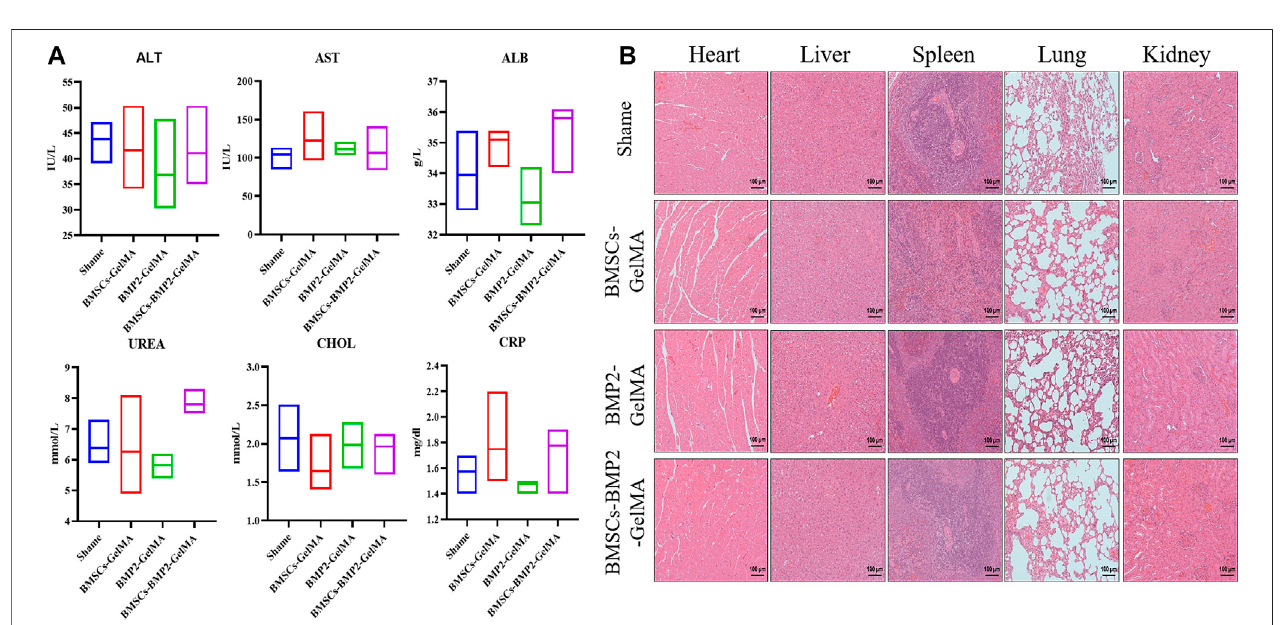
FIGURE 5 | Serum biochemical test (A) and histological examination (B) results of SD rats treated with BMSCs-GelMA scaffolds, BMP2-GelMA scaffolds and BMSCs-BMP2-GelMA scaffolds, respectively (bar = 100 μ m).